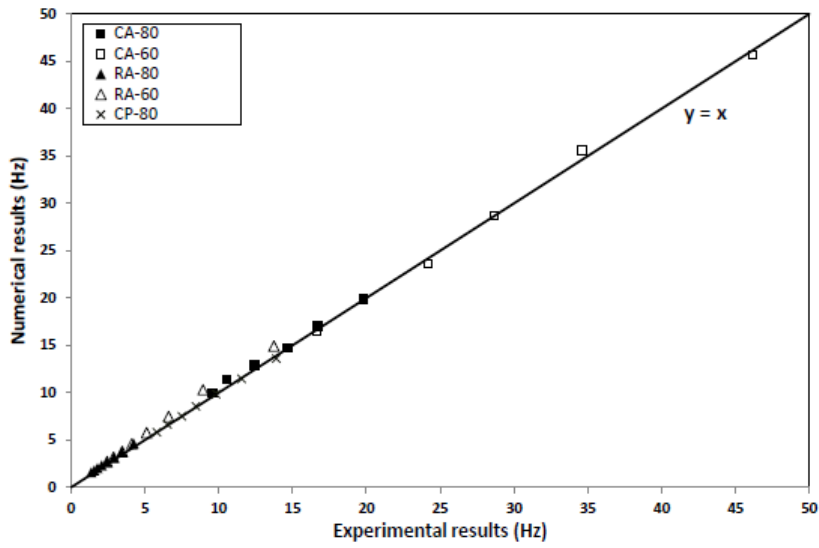
Figure 8. Comparison of experimental and numerical first frequencies of the tested rods (correlation coefficient of R 2 =